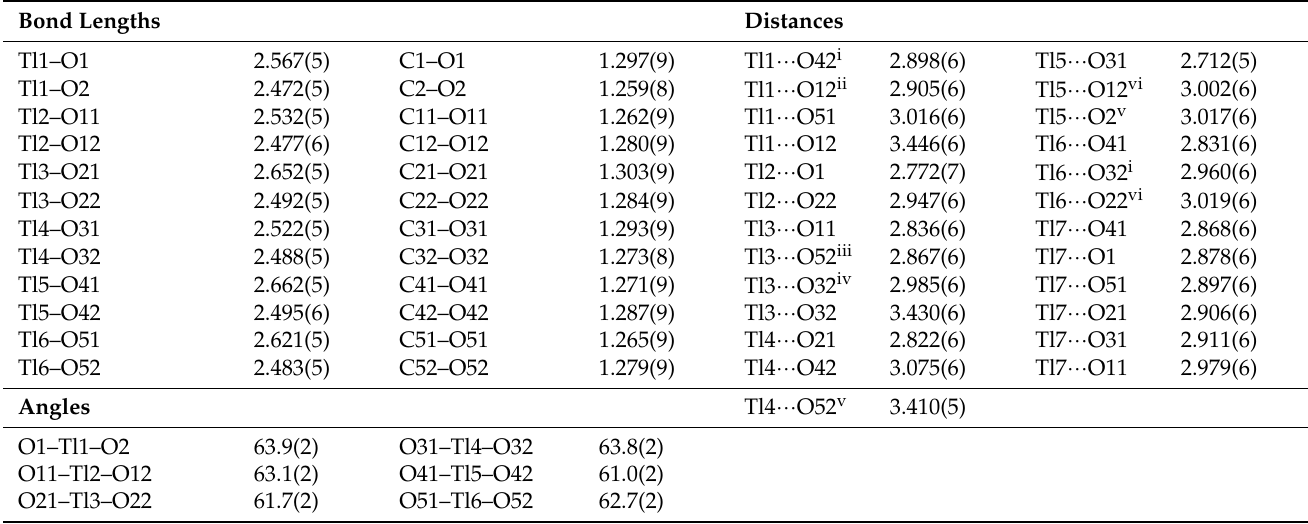
Table 4. Selected bond lengths, distances (Å), and angles ( ◦ ) for compound 4